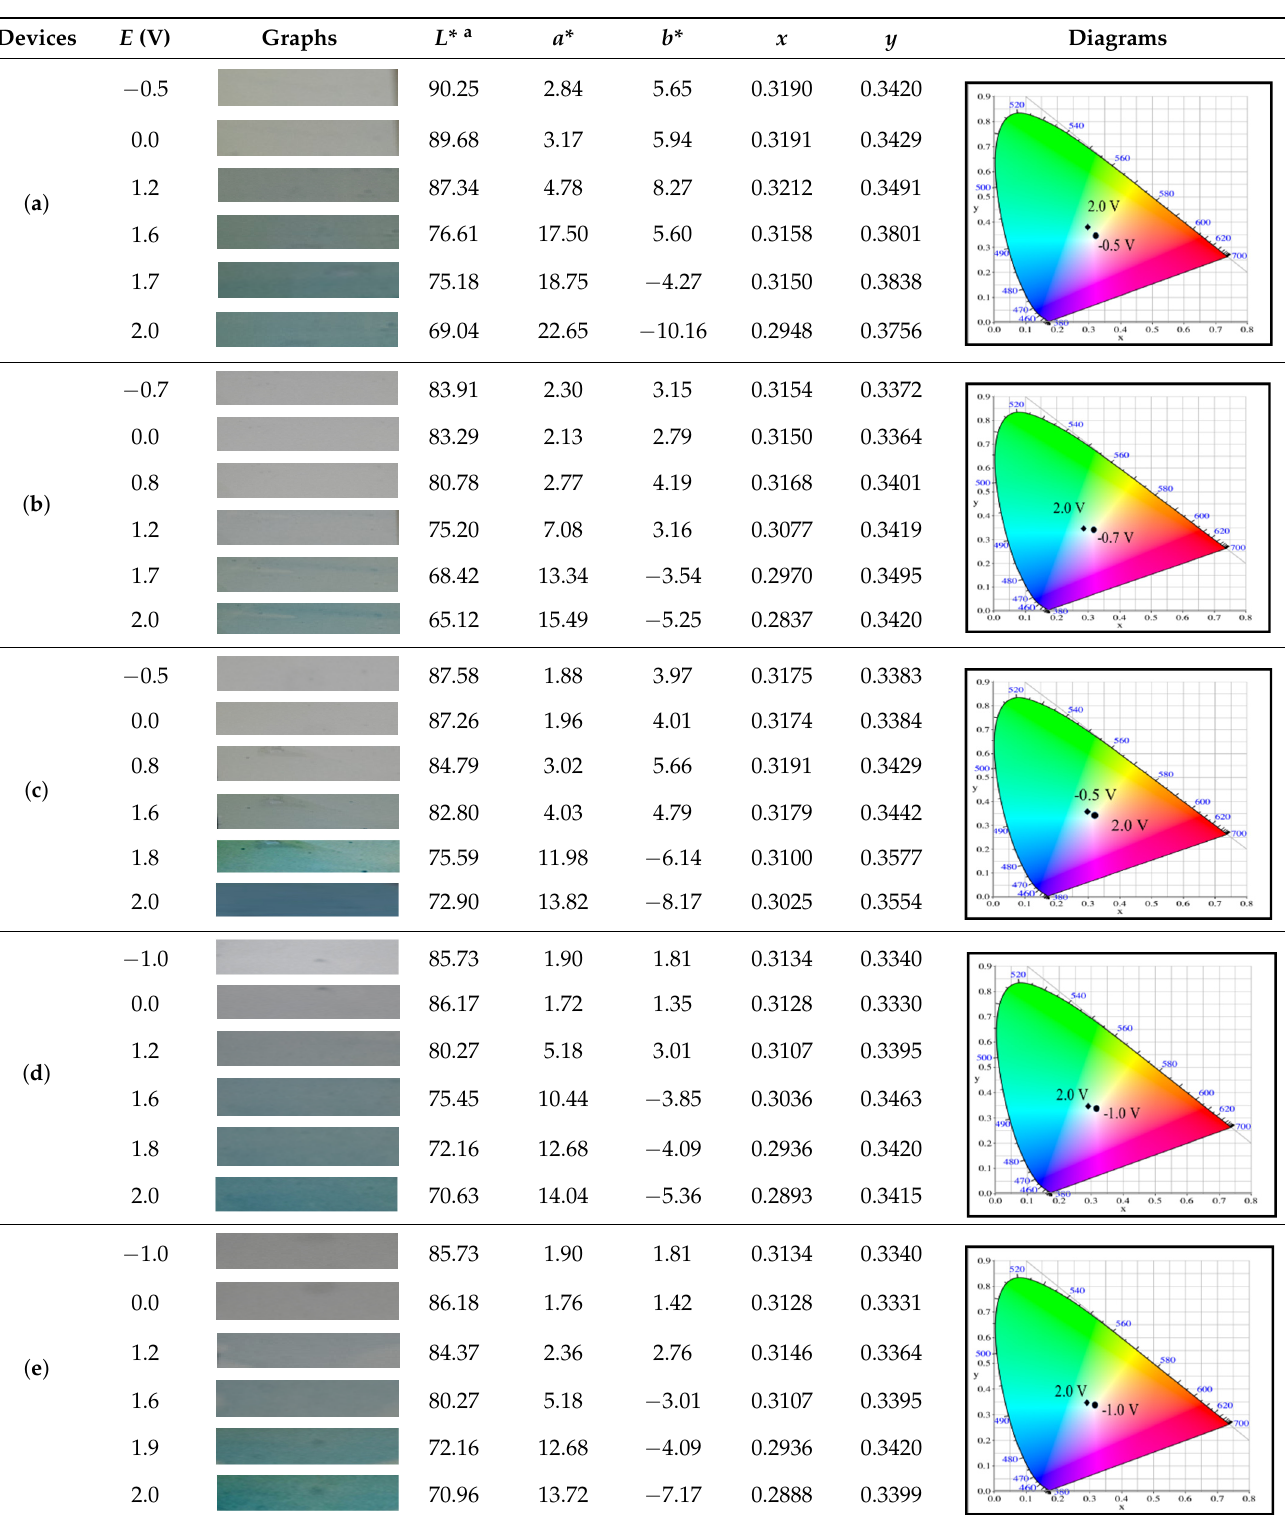
Table 5. Chromaticity diagrams of the ( a ) P(DCB)/PEDOT-PSS, ( b ) P(DCB- co -ED)/PEDOT-PSS, ( c )